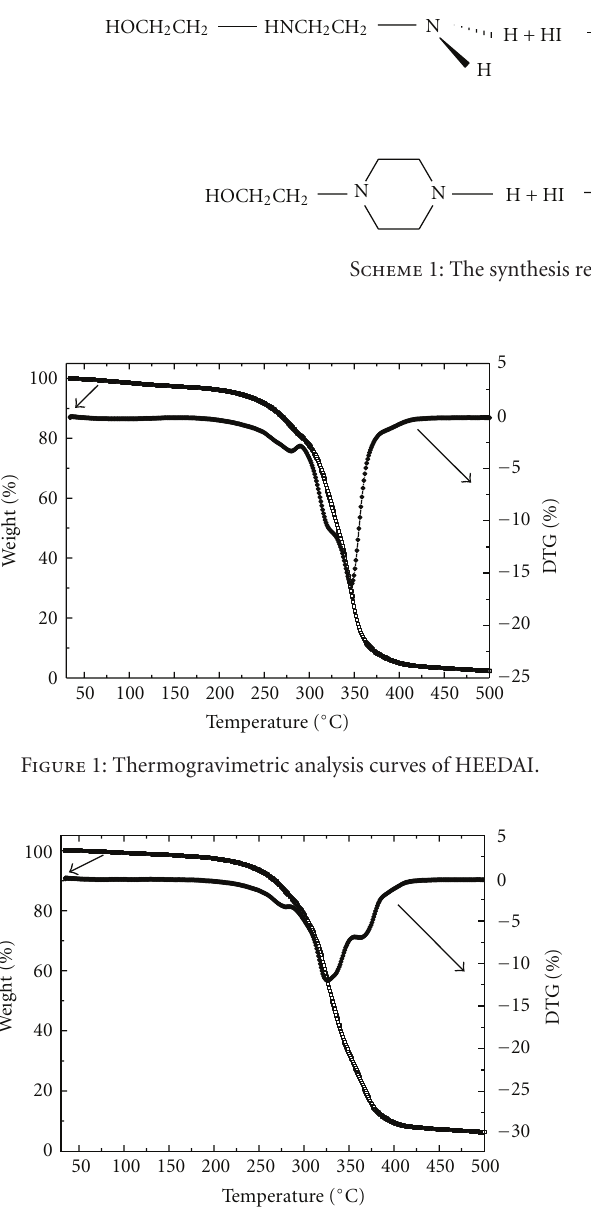
Figure 2: Thermogravimetric analysis curves of HEPI.